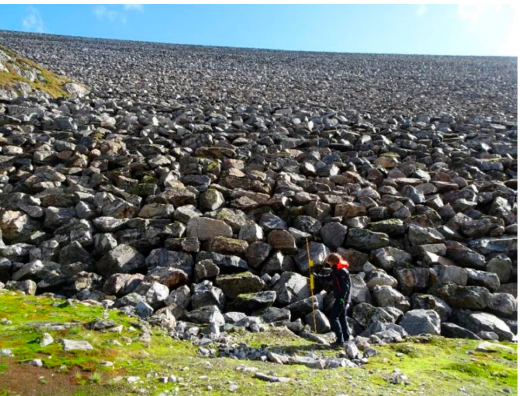
Figure 1. Placed riprap constructed on the downstream slope of Oddatjørn dam, a 142 m high rockfill dam built in Suldal, Norway [2].